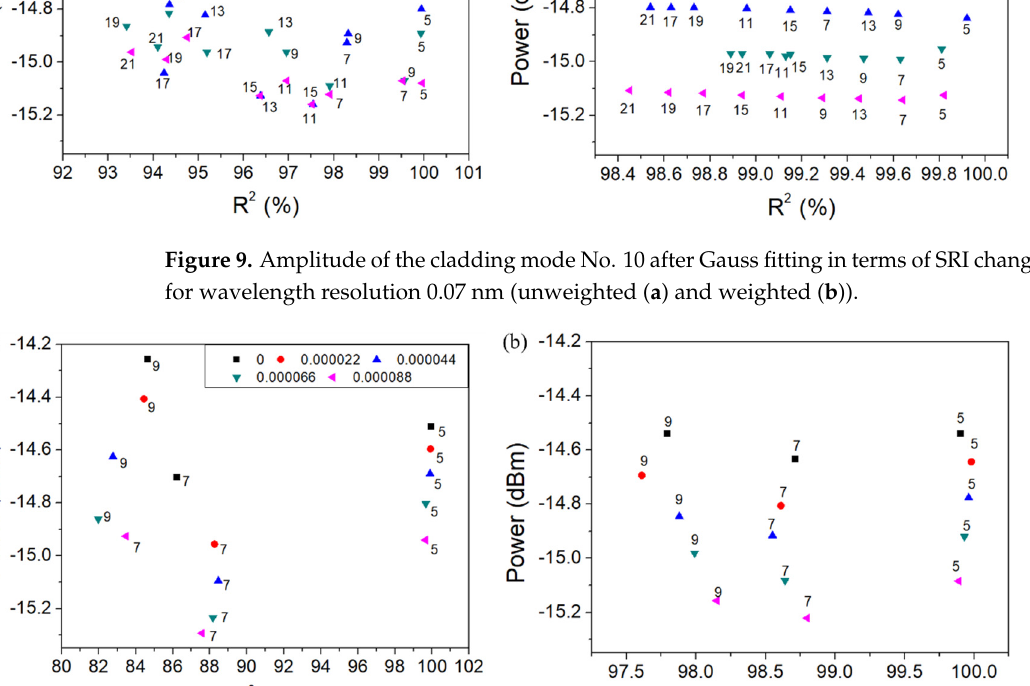
weighted Gauss fitting are − 6307 dB/RIU and − 6721 dB/RIU, respectively, as shown